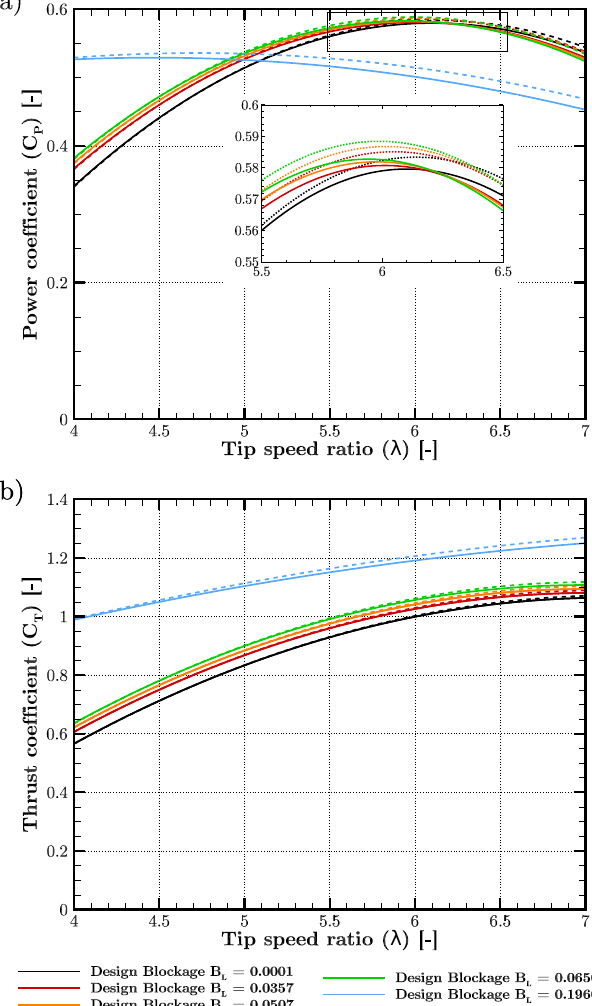
Fig. 5. Variation in (a) rotor power coefficient, C P , and (b) thrust coefficient, C T , with tip speed ratio λ for the five rotor designs in the multi-rotor configuration with an inter-turbine spacing s/d = 1 ( B L = 0 . 1960) , and a global blockage ratio B G = 0 . 0507 . Power and thrust coefficients for inboard rotors are indicated with dashed lines, and solid lines for outboard